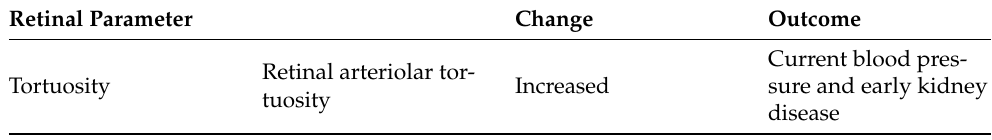
Table 3. Retinal vascular parameters and their influence in target end-organ damage and CVD [36]. Retinal